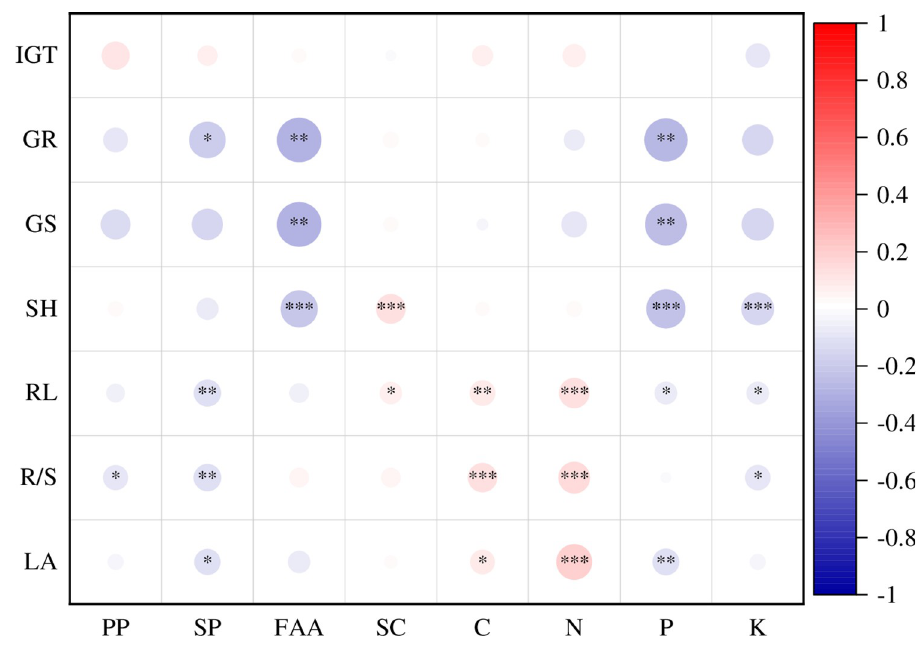
Fig 3. The relationships between seed germination and seedling growth indices of L . sativa and extract components of A . philoxeroides . PP, SP, FAA, SC, C, N, P and K represent plant polyphenol, soluble protein, free amino acids, soluble carbohydrate, carbon, nitrogen, phosphorus and potassium. ‘ � ’, ‘ �� ’ and ‘ ��� ’ signify p < 0.05, p < 0.01 and p < 0.001,